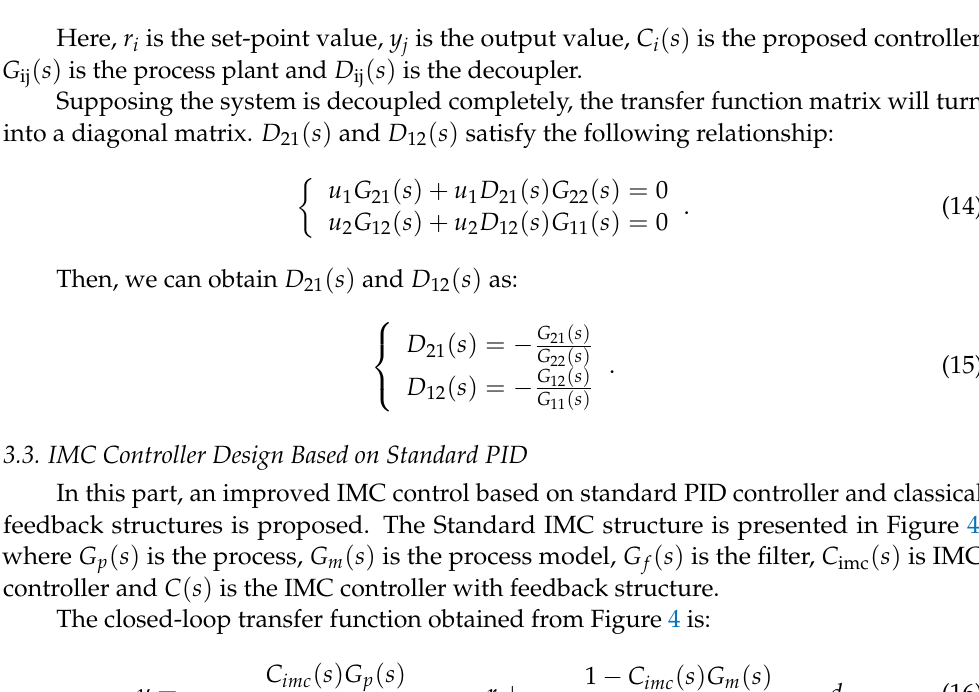
Figure 3. The block diagram of a feed-forward decoupling structure for a two-input and two-output